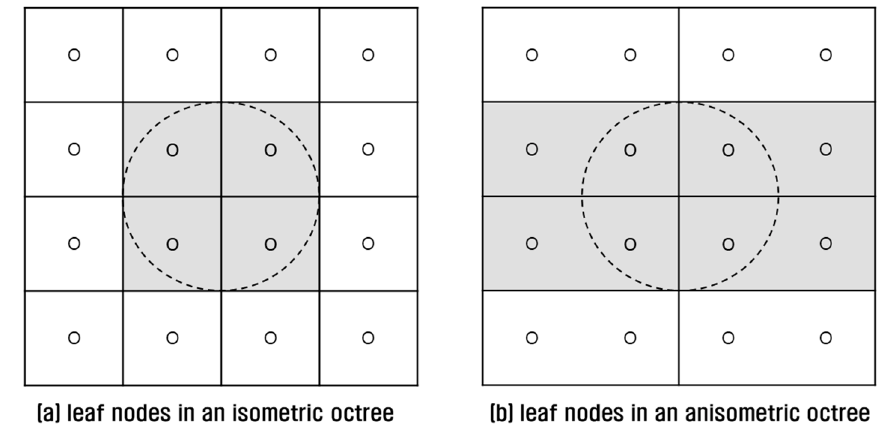
Figure 7. Comparison of leaf nodes: ( a ) in an isometric octree; ( b ) in an anisometric octree.